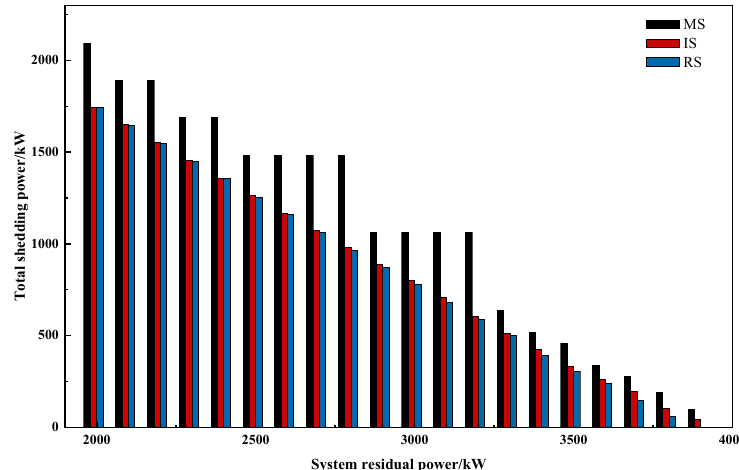
Figure 6. Comparison of the total shed power after the load shedding.